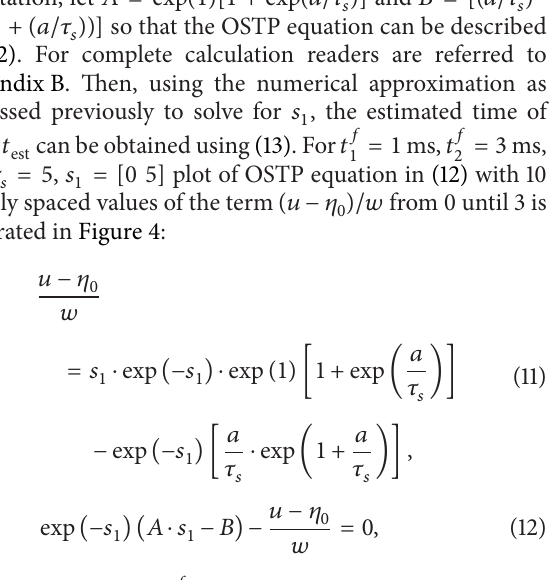
= 1 ms, 𝑡 𝑓 = 3 ms, and 1 2